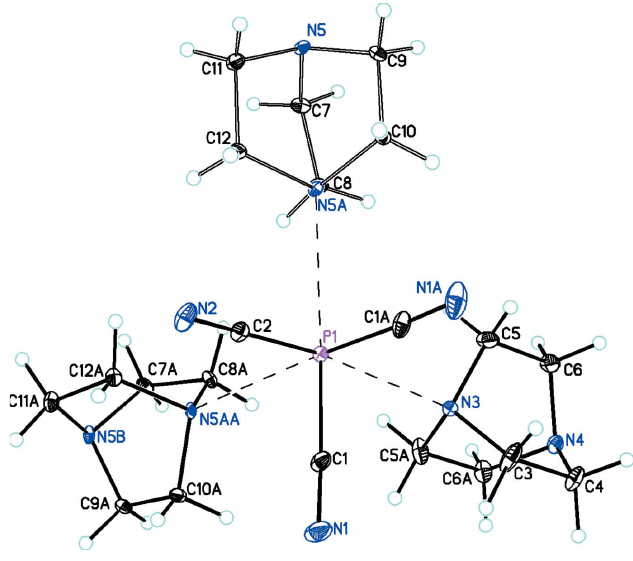
Figure 3 Diagram for 2 showing the distorted octahedral coordination geometry of the P atom. Interactions with the C 6 H 12 N 2 units are shown as dashed bonds. Atomic displacement parameters are at the 30% probability level. The symmetry code to generate the P1 (cid:3)(cid:3)(cid:3) N5 A interaction is 1 (cid:4) x , 1 (cid:4) y , 2 (cid:4) z , and for the P1 (cid:3)(cid:3)(cid:3) N5 AA interaction is 1 (cid:4) x , y (cid:4) 1